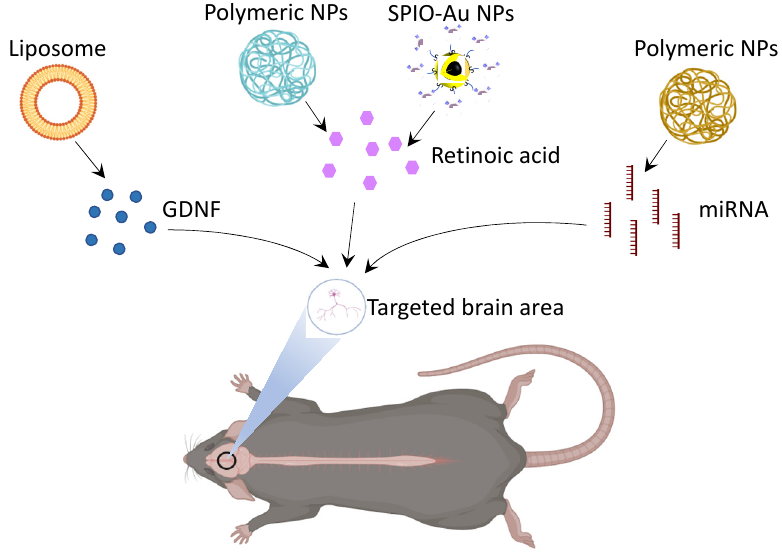
Figure 5. Schematic illustration of drugs and associated drug-delivery systems as potential treatments for ND. (Created with BioRender.com on 18 April 2022).